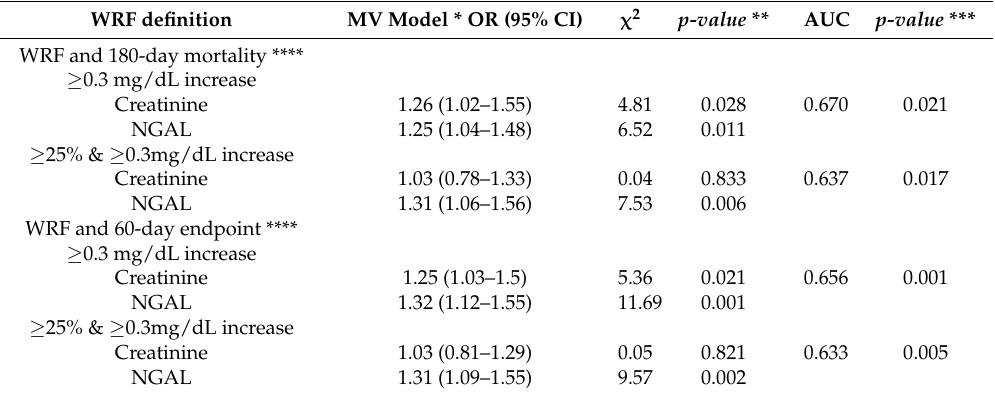
Table 4. Added value of NGAL on top of creatinine for predicting clinically relevant